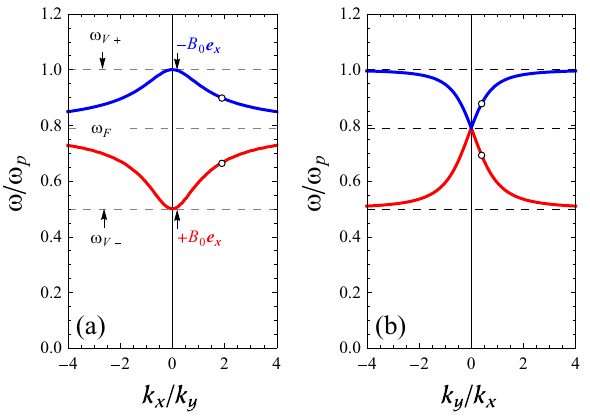
Figure 3. Dispersion curves of SMPs at a flat magnetized electron gas-vacuum interface, as obtained from 0.5 ω p . ( a ): k y is constant (positive). ( b ): k x is constant (positive). In both panels, we map out the Eq. (9) for ω c = two-dimensional band structure of the magnetoplasmons, making use of the fact that by Eq. (9) the frequency only depends on the fraction k x / k y rather than on both wavevectors separately. This special property makes the band structure effectively